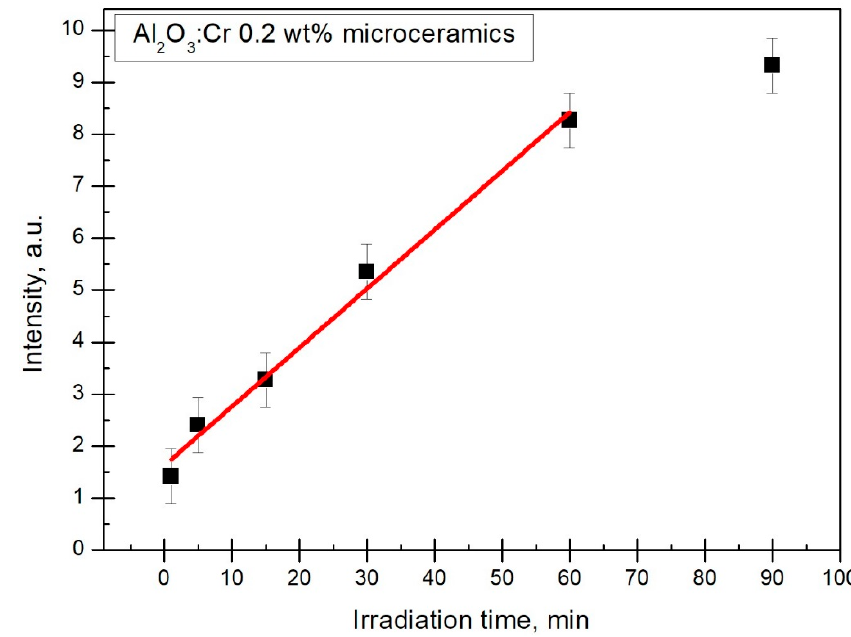
Figure 10. TL intensity dependence on irradiation time with a linear fit for Al (cid:2870) O (cid:2871) : Cr with 0.2 wt% Cr (cid:2870) O (cid:2871) (only third peak is shown to avoid visual clutter).